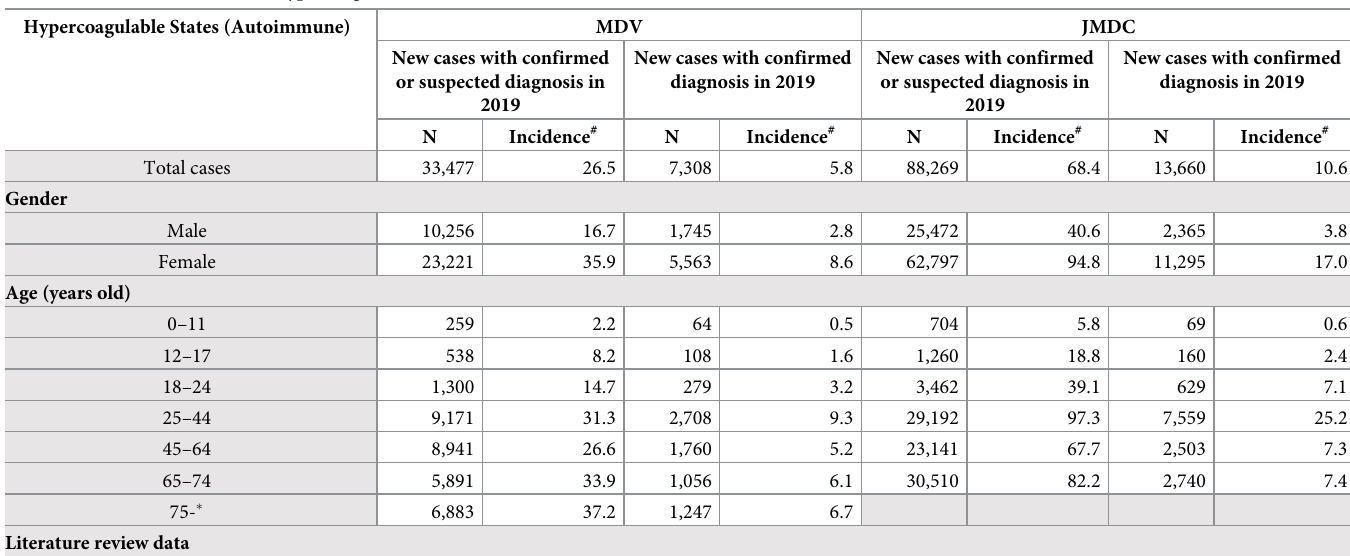
Table 9. Estimated incidence of Hypercoagulable States (Autoimmune). Hypercoagulable States (Autoimmune)